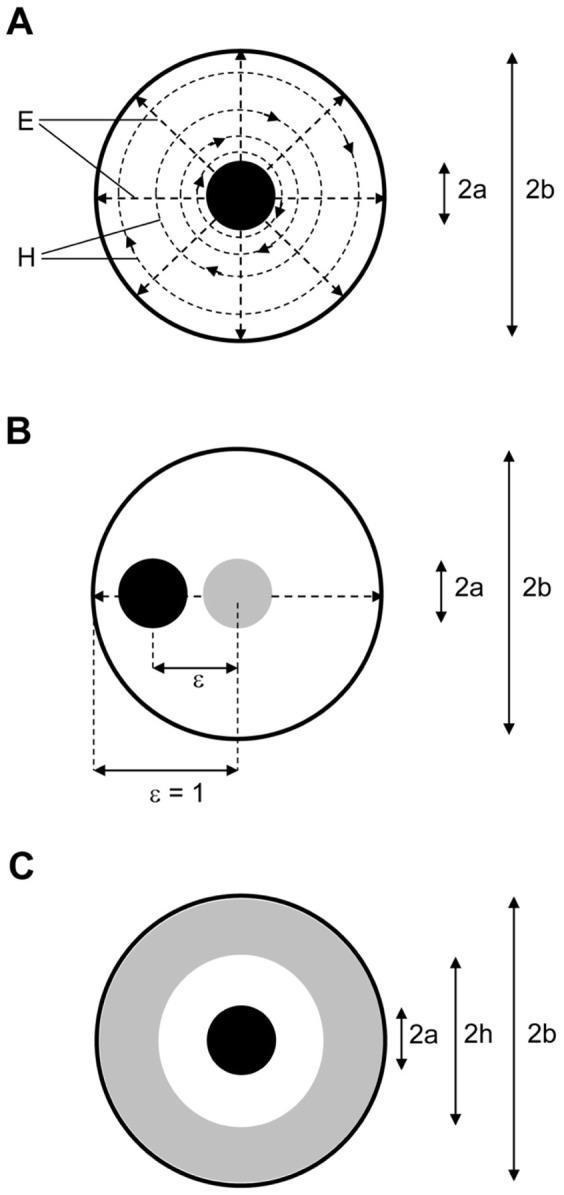
Cross sections of coaxial line.(A) Outline of electric (E) and magnetic (H) field lines; note radial the decrease in H-density. The outer diameter of the innner conductor is 2a and the inner diameter of the outer conductor is 2b. (B) Definition of eccentricity of an off-axis inner conductor. (C) Illustration of a coaxial cell in which a paramagnetic sample (white area) is contained in a diamagnetic holder (grey area).